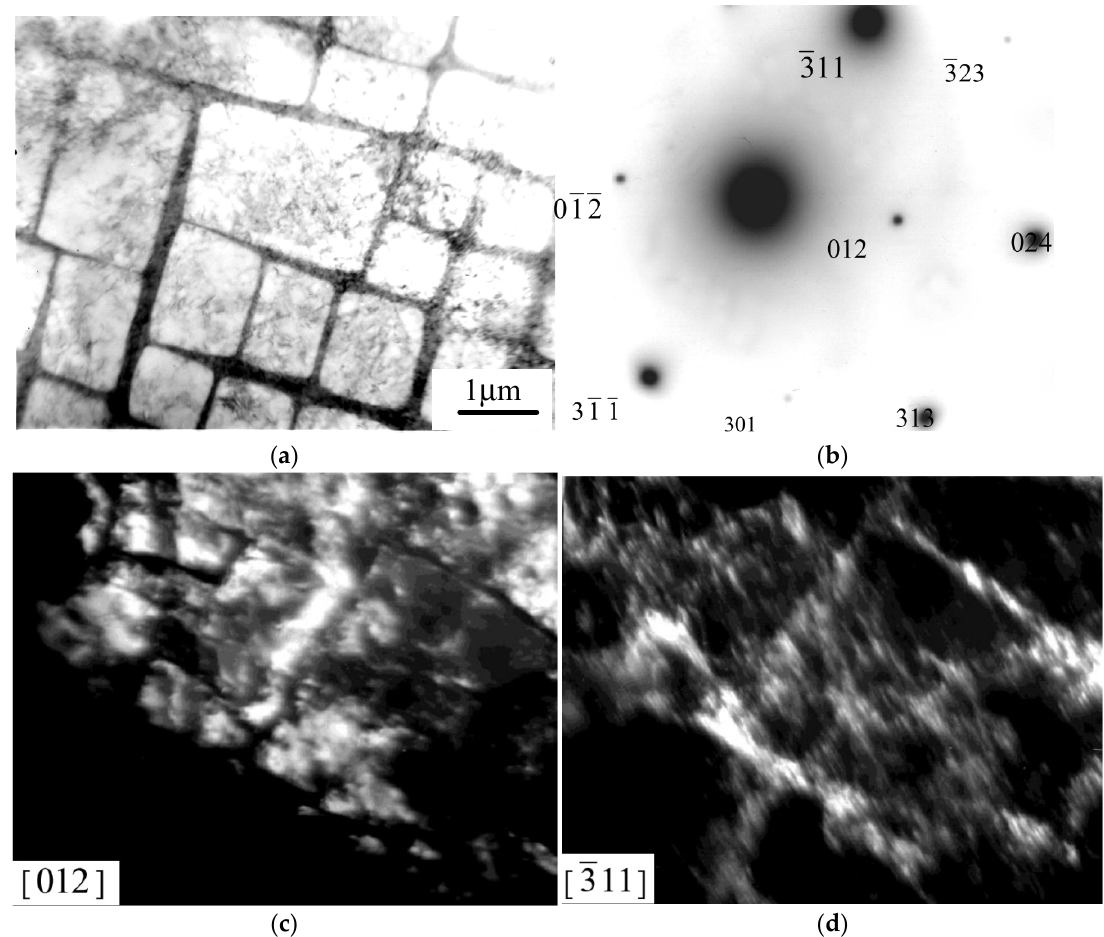
Figure 2. Electron microscopic image of a quasi-cuboid structure ( γ (cid:48) + γ ) in the alloy after DC (structural phase state “A”): ( a ) bright-field image; ( b ) indicated microdiffraction pattern; ( c , d ) dark-field images obtained, respectively, in the superstructure reflection [012] and the main reflection